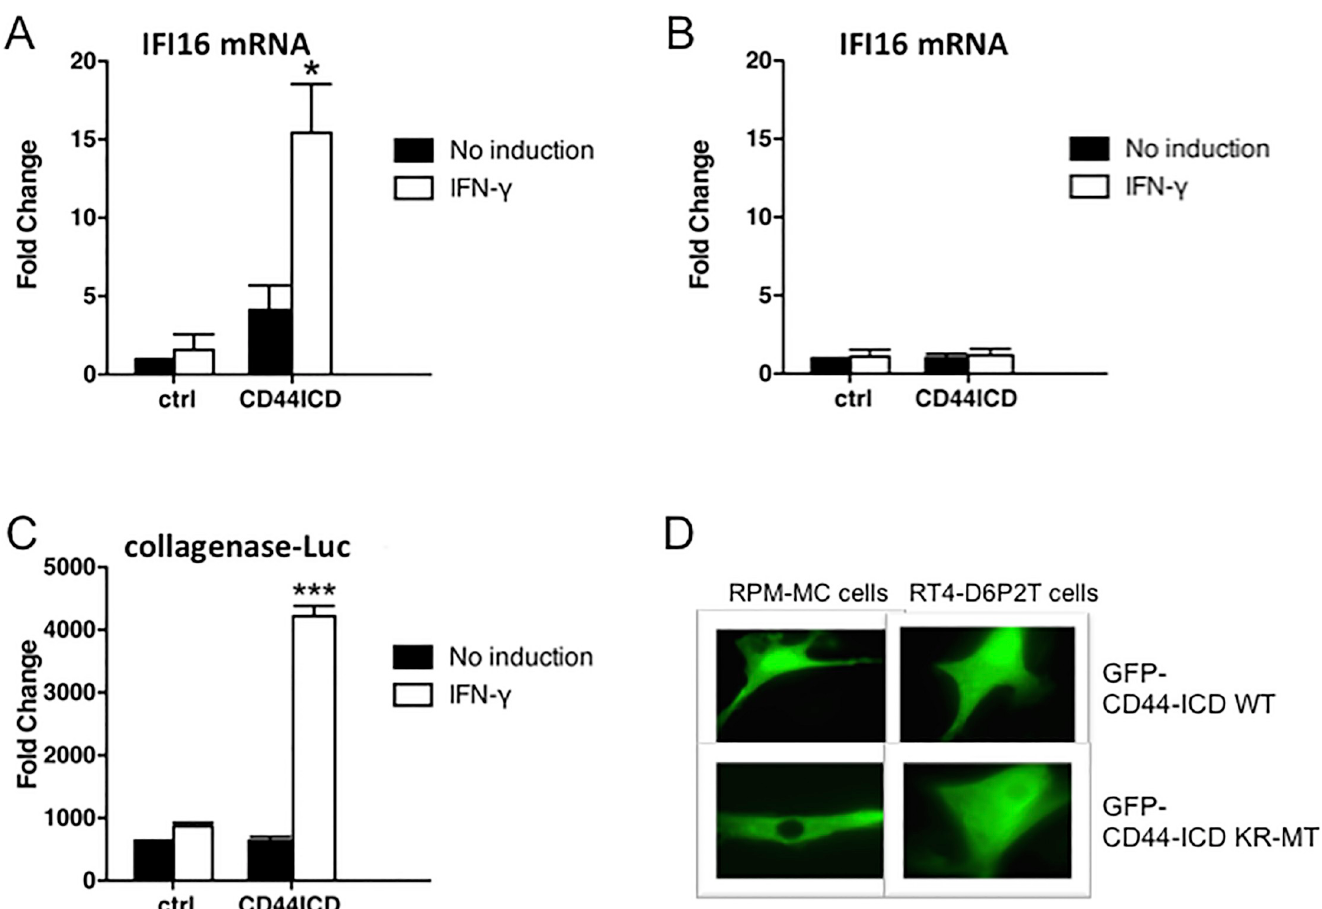
Fig 3. IFI16 up-regulation is implemented at the level of transcription. (A ) RPM-MC cells were prepared as in Fig 2 and transfected with a control vector or a vector expressing the CD44-ICD as described above. ( B ) Immediately before treating cells with IFN- γ (100 ng/ml, 6 h), actinomycin D (5 μ g/ml) was added to the cells. RNA was analysed as described in Fig 2. ( C ) RPM-MC cells were seeded in 24-well plates at a density of 4x10 4 cells/well. 24 h later cells were transiently transfected with either a control vector or CD44-ICD together with a construct of collagenase 1 promoter fused to the firefly-luciferase gene. Transfection medium was exchanged to fresh medium after 14 h. Overnight treatment with IFN- γ (100 ng/ml) was followed by analysis. Luminescence was measured after addition of Firefly-luciferase substrate. ( D ) Cells were transiently transfected with GFP-tagged wild type or KR-MT intracellular domain of CD44 (CD44-ICD). After 24 h, cells were fixed with 4% PFA and examined by microscopy (Axiovert 135). RPM-MC cells: 46 cells of total 50 cells showed nuclear localisation of wild type CD44-ICD; 32 cells of total 50 cells showed cytoplasmic localization of mutant CD44-ICD. RT4-D6P2T cells: 45 cells of total 50 cells showed nuclear localisation of wild type CD44-ICD; 30 cells of total 50 cells showed cytoplasmic localization of mutant CD44-ICD. Experiments were done in triplicates. For statistics see Materials and methods.